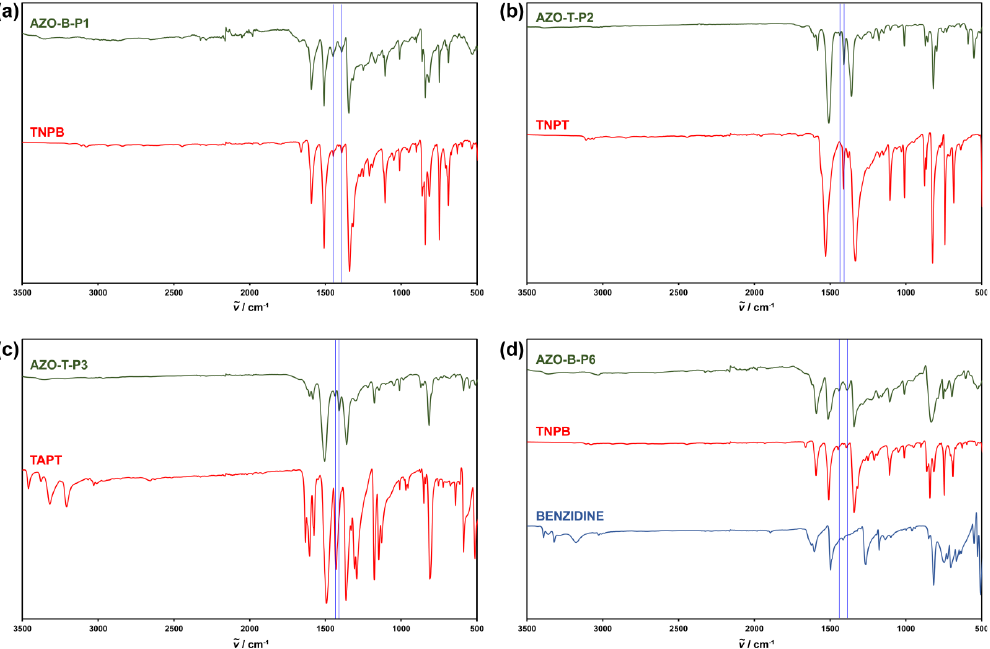
Figure 2. Comparison of representative FTIR spectra of ( a ) AZO-B-P1 polymer and starting nitro monomer (TNPB); ( b ) AZO-T-P2 polymer and starting nitro monomer (TNPT); ( c ) AZO-T-P3 polymer and starting amino monomer (TAPT); ( d ) AZO-B-P6 polymer and starting nitro and amino monomers (TNPB and benzidine, respectively). Signals attributed to the stretching vibrations of the azo (−N=N−) group in polymers are marked with vertical lines.